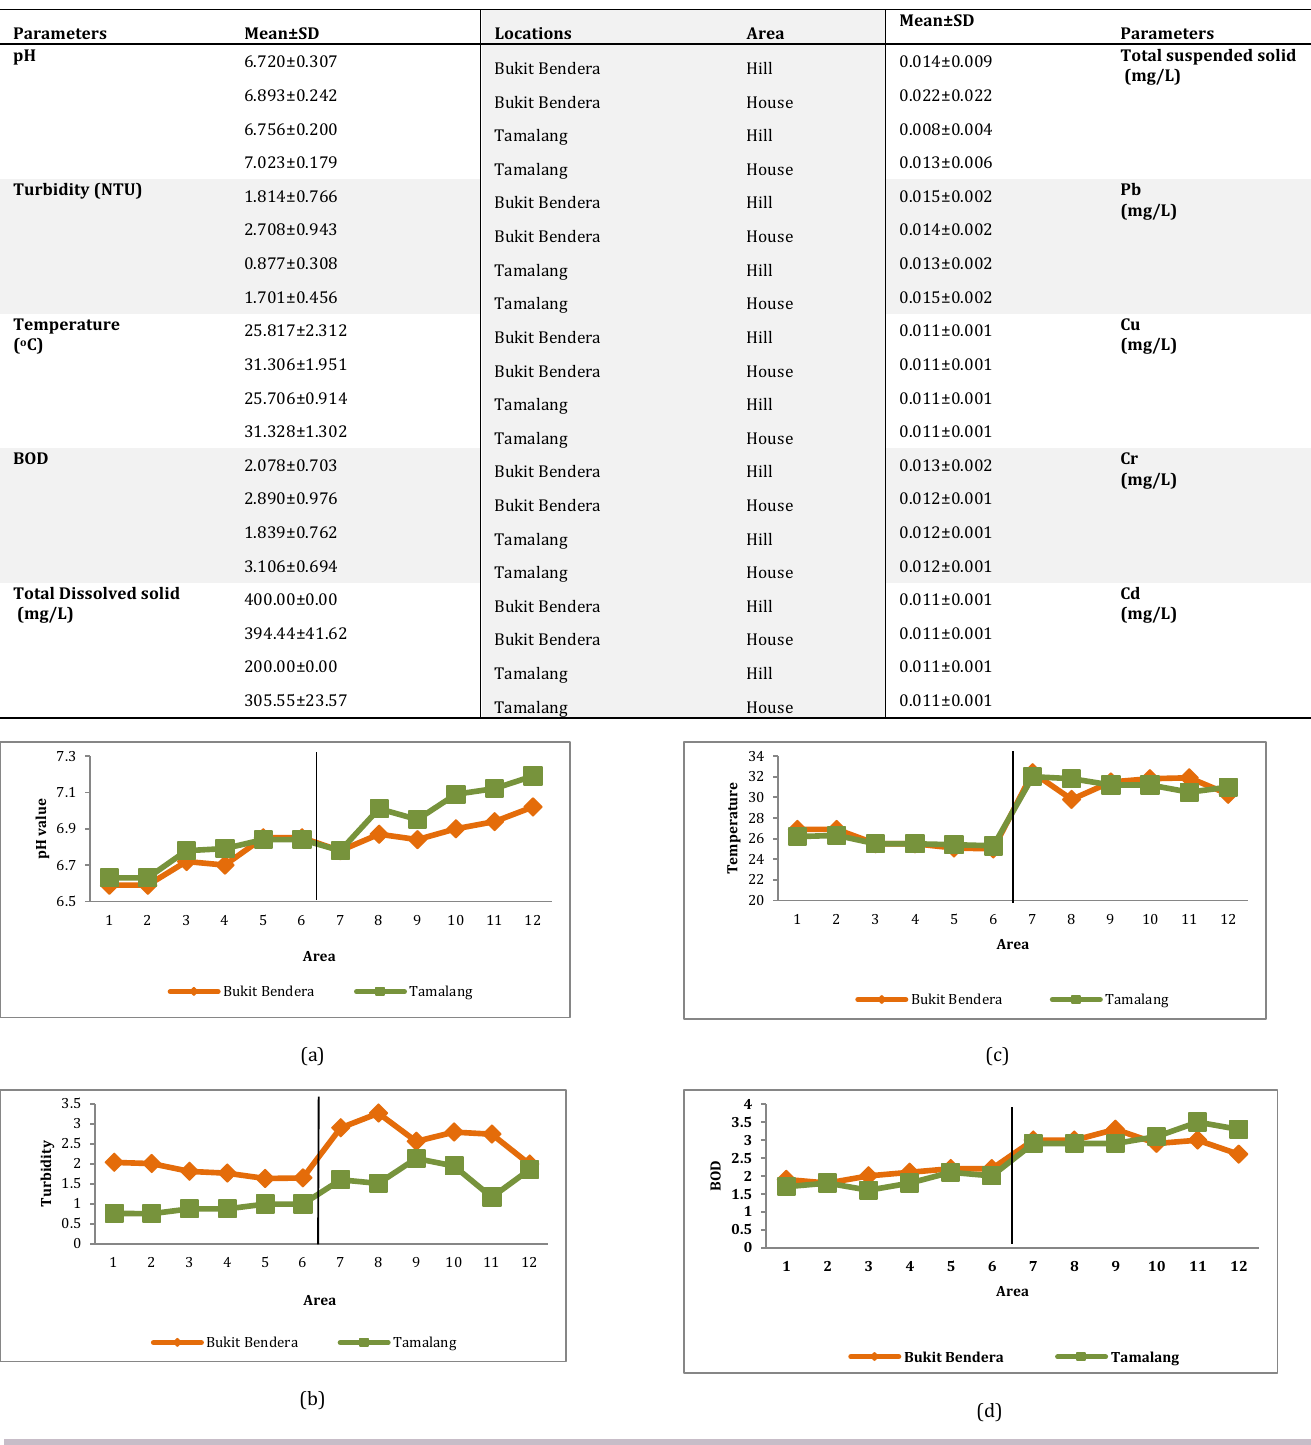
Table 2: The mean concentrations of parameters in spring-water from Bukit Bendera and Tamalang village for three-time samplings, Kota Belud, Sabah. Parameters